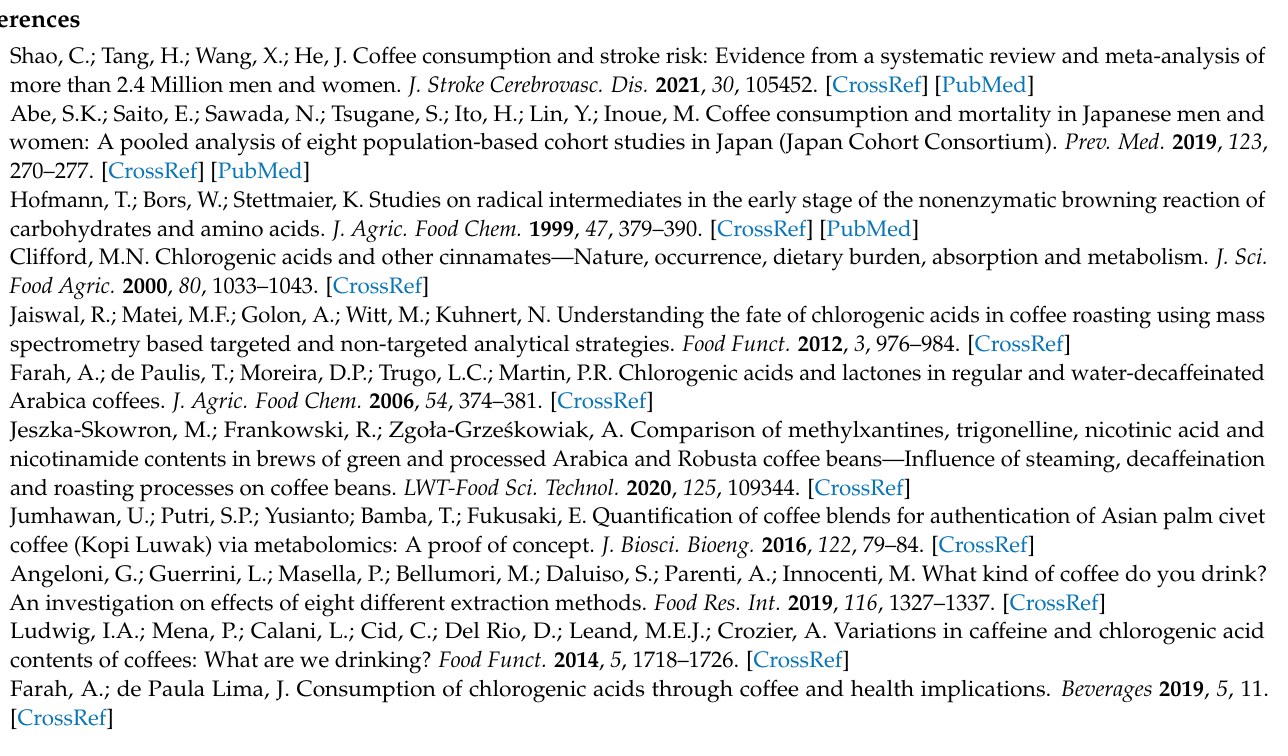
Models Arabica Brazil Mogiana green coffee; Table S5. ANOVA for Response Sur-face Models Arabica Brazil Mogiana roasted coffee; Table S6: ANOVA for Response Surface Model Robusta Vietnam green coffee; Table S7: ANOVA for Response Surface Models Robusta Vietnam roasted coffee; Figure S1: Model graph of caffeine for Arabica Mogiana medium roasted coffee brew; Figure S2: Model graph of caffeine for Robusta Vietnam green coffee brew; Figure S3: Model graph of 4,5-diCQA for Robusta Vietnam green coffee brew; Figure S4: Model graph of caffeine for Robusta Vietnam medium roasted coffee brew; Figure S5: Model graph of theobromine (THB) for Robusta Vietnam medium roasted coffee